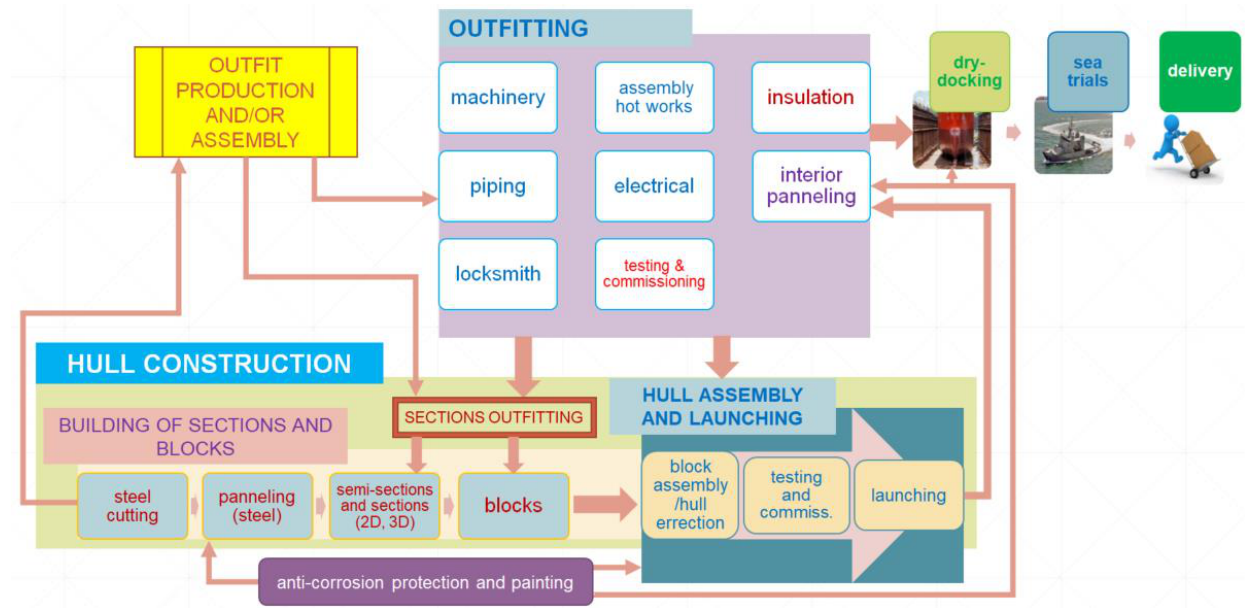
Figure 4. New build outfitting process.